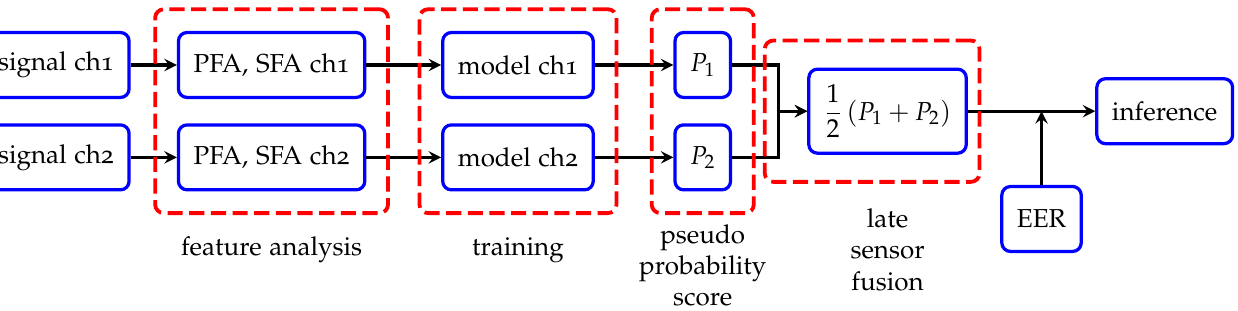
Figure 3. A schematic view of workflow in our approach. Channel 1 and channel 2 are abbreviated as ch1 and ch2, respectively. P 1 and P 2 denote pseudo probability scores obtained from trained models with channel 1 and channel 2,